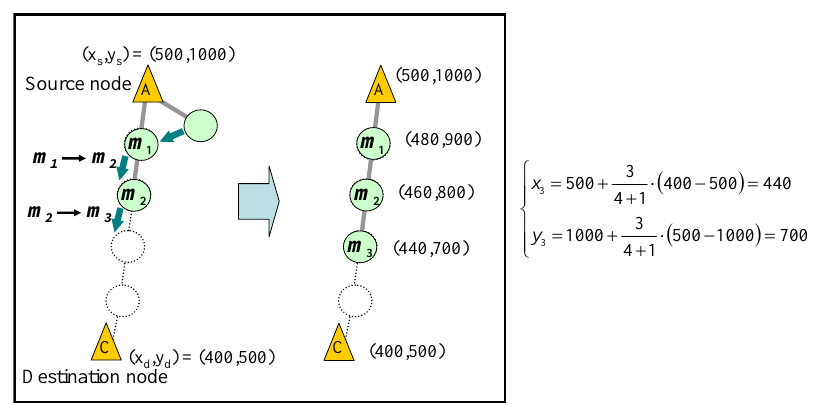
Figure 8. Reconstruction of a train.